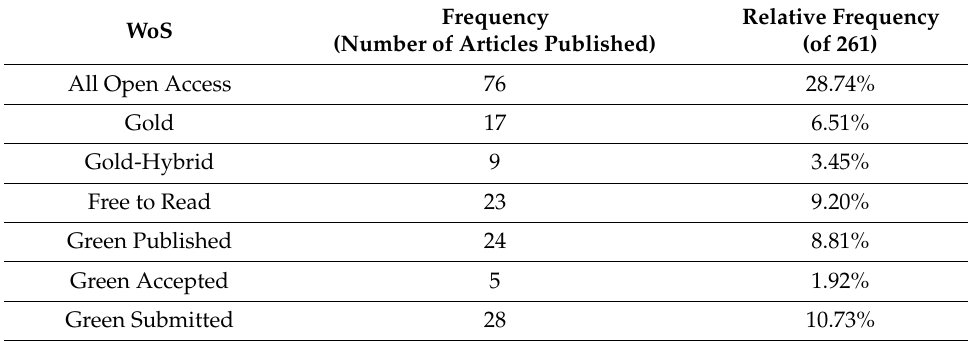
Table 3. Classification of open access articles in